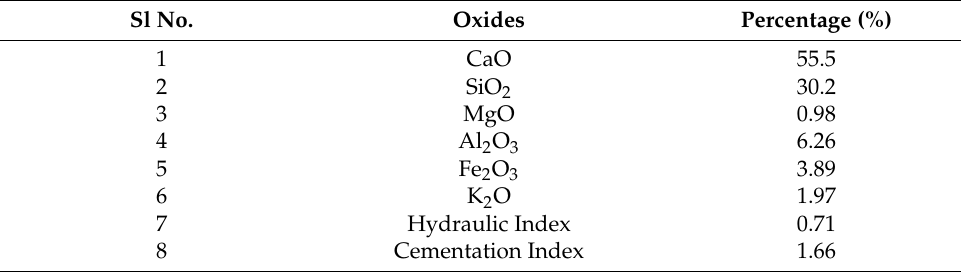
Table 1. Chemical composition of the hydraulic lime. Sl